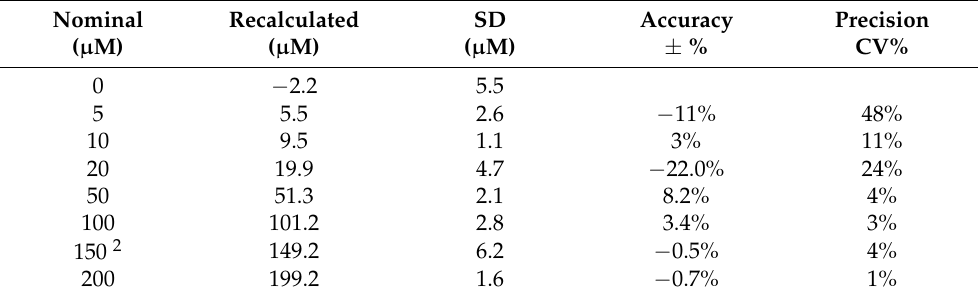
Table 2. The accuracy and precision of the nitrate measurement 1